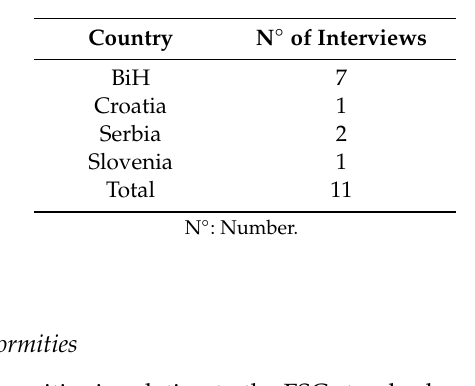
Table 4. The number of interviewees by countries.